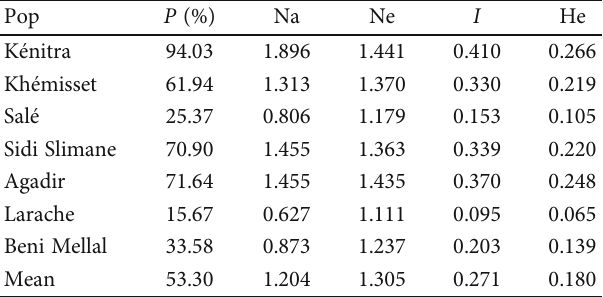
Table 5: Summary of genetic diversity indices of Alternaria isolates collected from seven provinces of Morocco based on SRAP